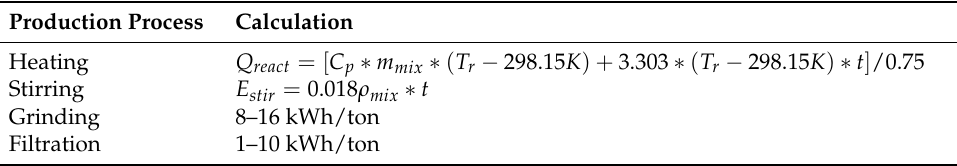
Table 3. Calculation methodology adopted from Piccinno et al. [46] to perform the scale up of the energy consumption from laboratory scale to industrial scale. C p = Specific heat capacity [J/(kg*K)]; m mix = mass of the reaction mixture (kg); T r = temperature of reaction (K); t = time of reaction (s); ρ mix = density of the mixture